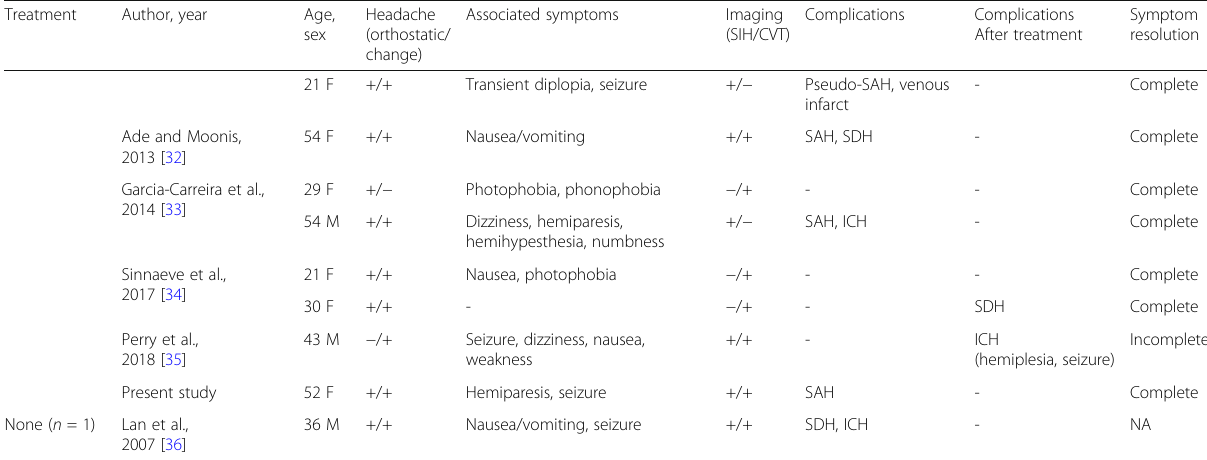
Table 1 Clinical and radiologic data for 42 patients with CVT (Continued)